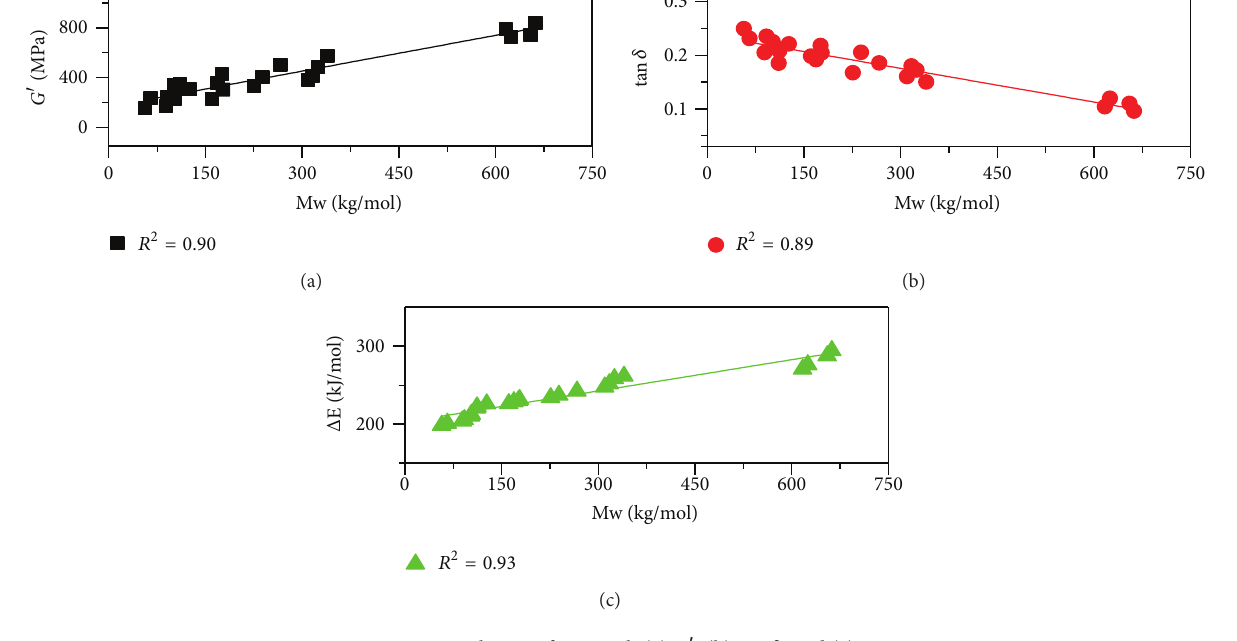
Figure 5: Correlation of Mw with (a) 𝐺 󸀠 , (b) tan 𝛿 , and (c) Δ𝐸 .